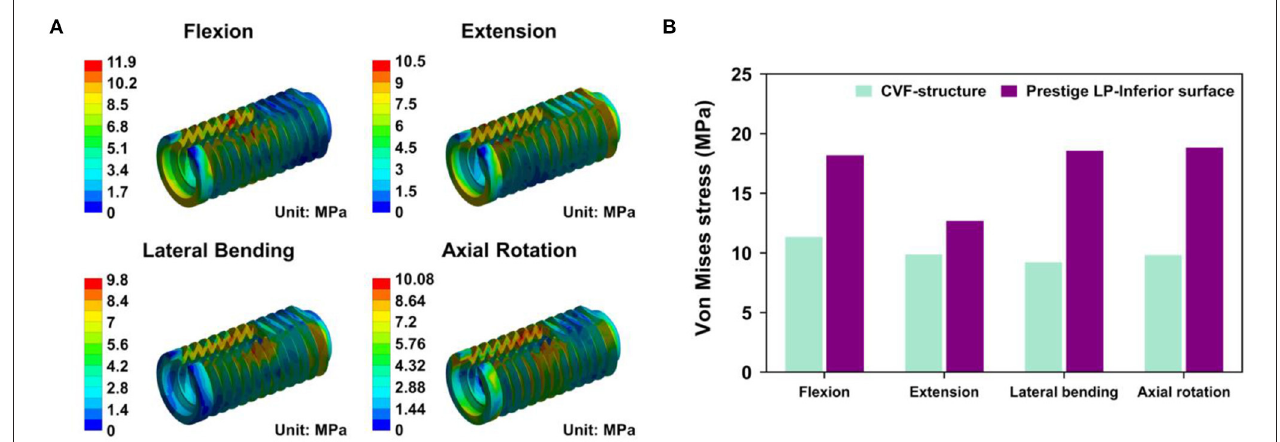
FIGURE 8 | Stress analysis of cervical subtotal discectomy prosthesis–cervical vertebra fixation (CSDP-CVF) structure. (A) Maximum stress for the CSDP-CVF structure finite element (FE) model, located nearby the link structure, instead of the bottom. (B) Maximum Von Mises stress analysis of CSDP-CVF structure FE models. Maximum stress in the CVF structure was less than that of the Prestige LP inferior surface in all loads.